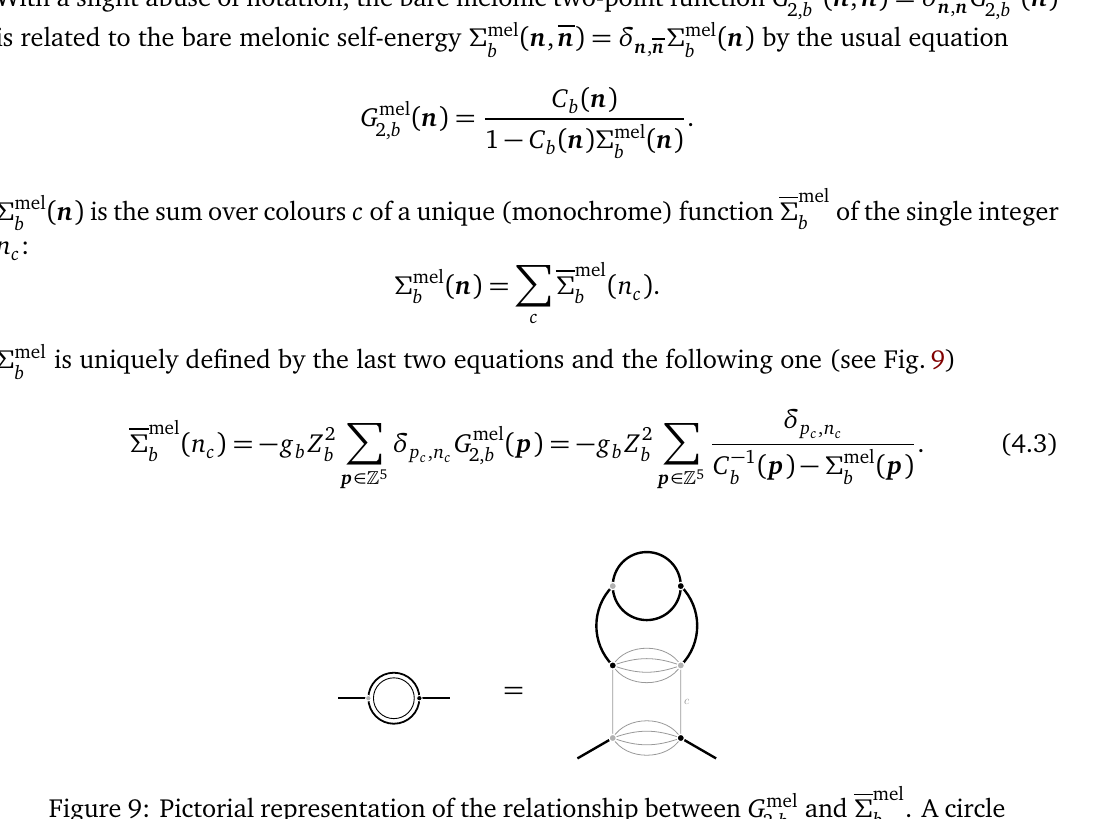
Figure 9: Pictorial representation of the relationship between G mel stands for a connected function, two concentric ones for a 1PI monochrome